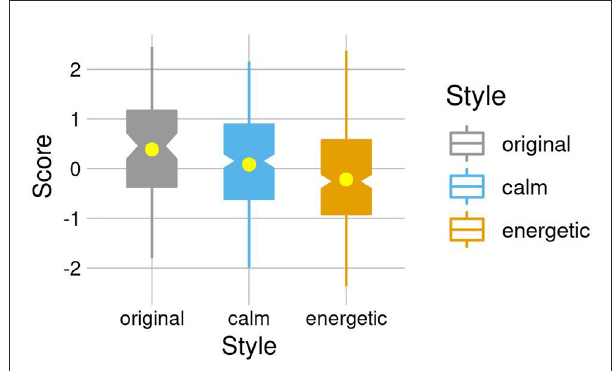
FIGURE1 The normalized likability scores for the original synthesized speech and the style-transferred calm and energetic advertising styles.